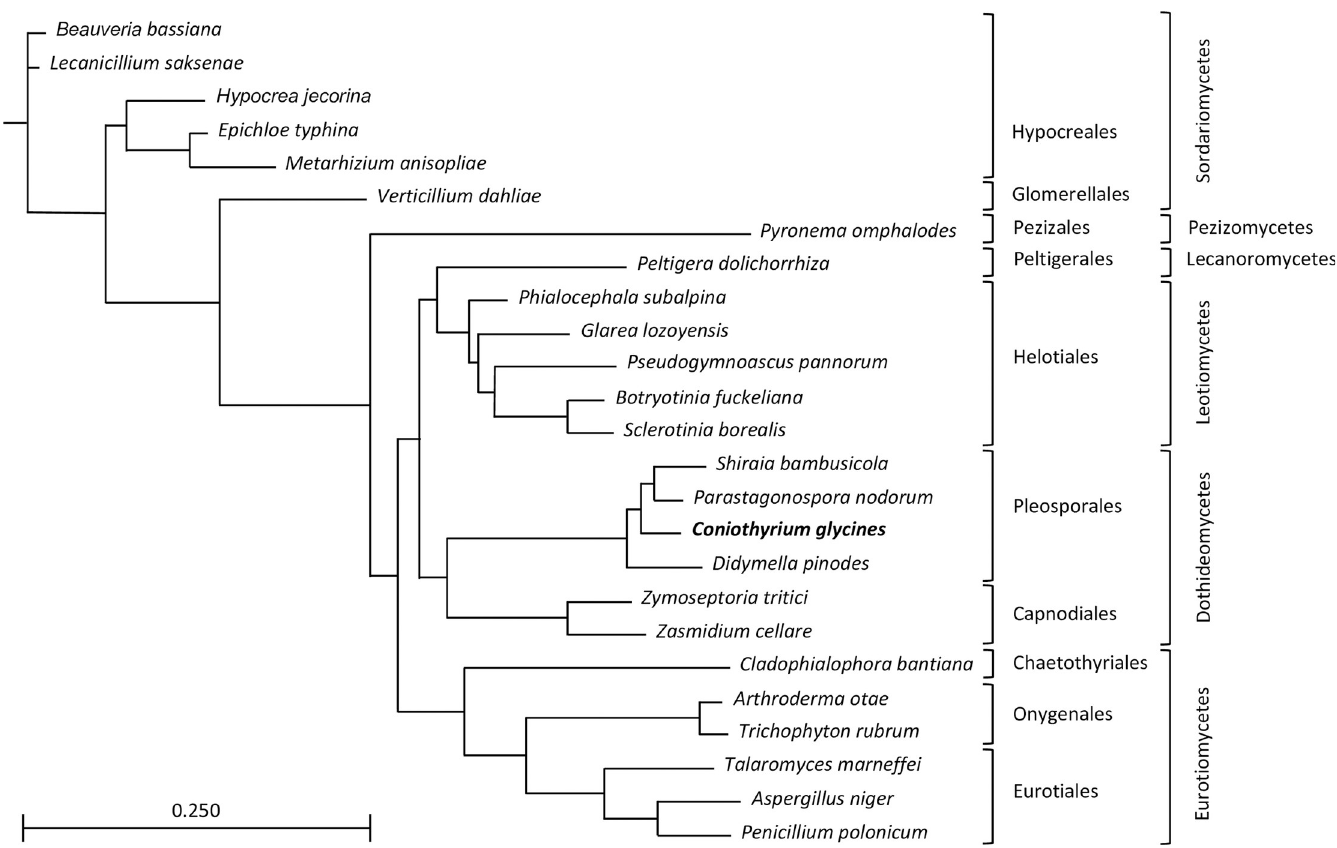
Fig 3. Phylogenetic tree constructed from unambiguously aligned portions of concatenated protein-coding sequences of twelve protein-coding genes shared in common among 25 fungal mt genomes. Topology shown was inferred with PhyML 3.0 using LG as the evolutionary model. Sequences were obtained from GenBank: Arthroderma otae (NC_012832); Aspergillus niger (NC_007445); Beauveria bassiana (NC_010652); Botryotinia fuckeliana (KC832409); Cladophialophora bantiana (NC_030600); Didymella pinodes (NC_029396): Epichloe typhina (NC_032063); Glarea lozoyensis (KF169905); Hypocrea jecorina (NC_003388); Lecanicillium saksenae (NC_028330); Metarhizium anisopliae (NC_008068); Parastagonospora nodorum (NC_009746); Peltigera dolichorrhiza (NC_031804); Penicillium polonicum (NC_030172); Pseudogymnoascus pannorum (NC_027422); Pyronema omphalodes (NC_029745); Sclerotinia borealis (NC_025200); Shiraia bambusicola (NC_026869); Talaromyces marneffei (NC_005256); Trichophyton rubrum (NC_012824); Verticillium dahliae (NC_008248); Zasmidium cellare (NC_030334); Zymoseptoria tritici (NC_010222); Phialocephala subalpina (NC_015789).